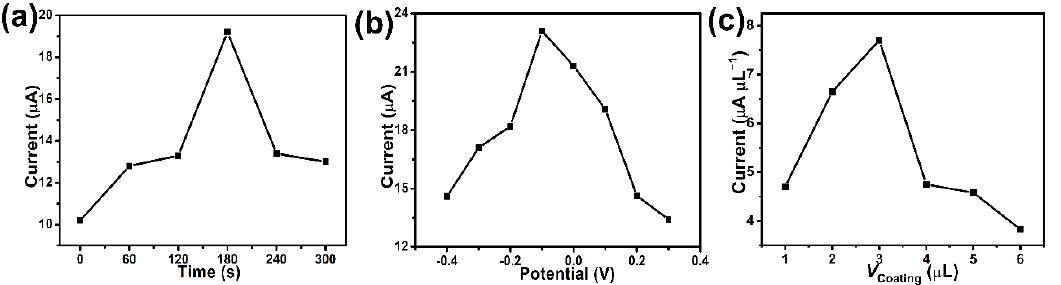
Figure 3. Effects of accumulation time ( a ), potential ( b ), coating amounts ( c ) of MI-Au-MoO 3 / r GO in 0.1 M phosphate buffer (pH = 7) containing 0.1 mM BPA. 0.1 M phosphate buffer (pH = 7) containing 0.1 mM BPA.